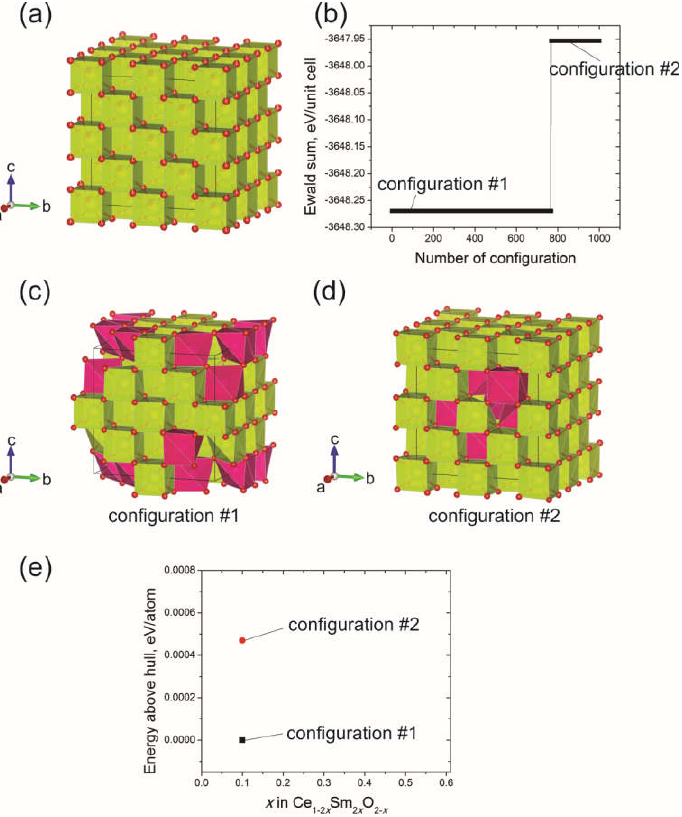
Figure 8. ( a ) Structure of Ce 0.8 Sm 0.2 O 1.9 : the light green, pink and red balls represent Ce, Sm and O atoms, respectively. 95% occupancy of O (red) is indicated by a partially colored site. Ce sites are partially occupied by Sm (19%); ( b ) Ewald summation results for all possible configurations of Ce 0.8 Sm 0.2 O 1.9 solid solution. View of configurations #1 and #2; ( c , d ) Ewald summation according to ( b ); ( e ) Energy above hull values for configurations #1 and #2. The results obtained using BVS analysis confirm the existence of large empty sites, which allow for fast oxygen diffusion (Figure 9). In this case, large cube-shaped cavities are present, connected by their vertices through narrow channels (Figure 9b). The value Δ BVS = 0.3 was used in the calculations.